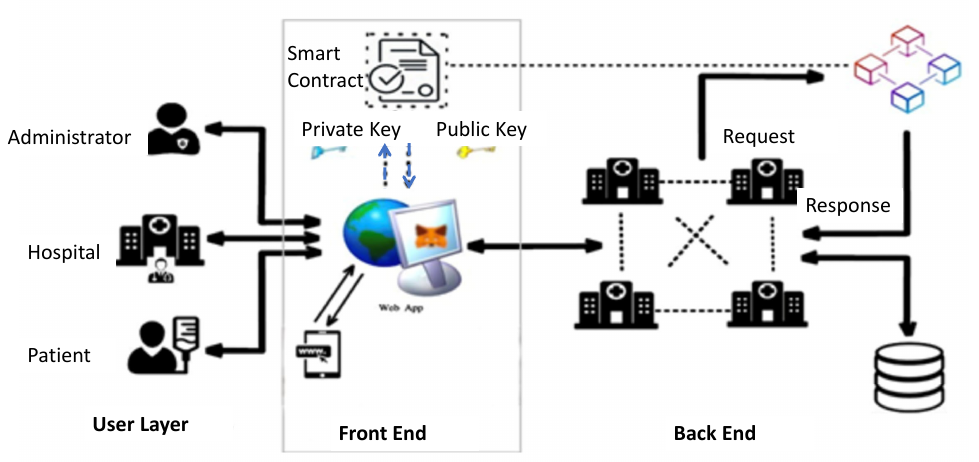
Figure 3. Blockchain framework for Electronic Health Records in